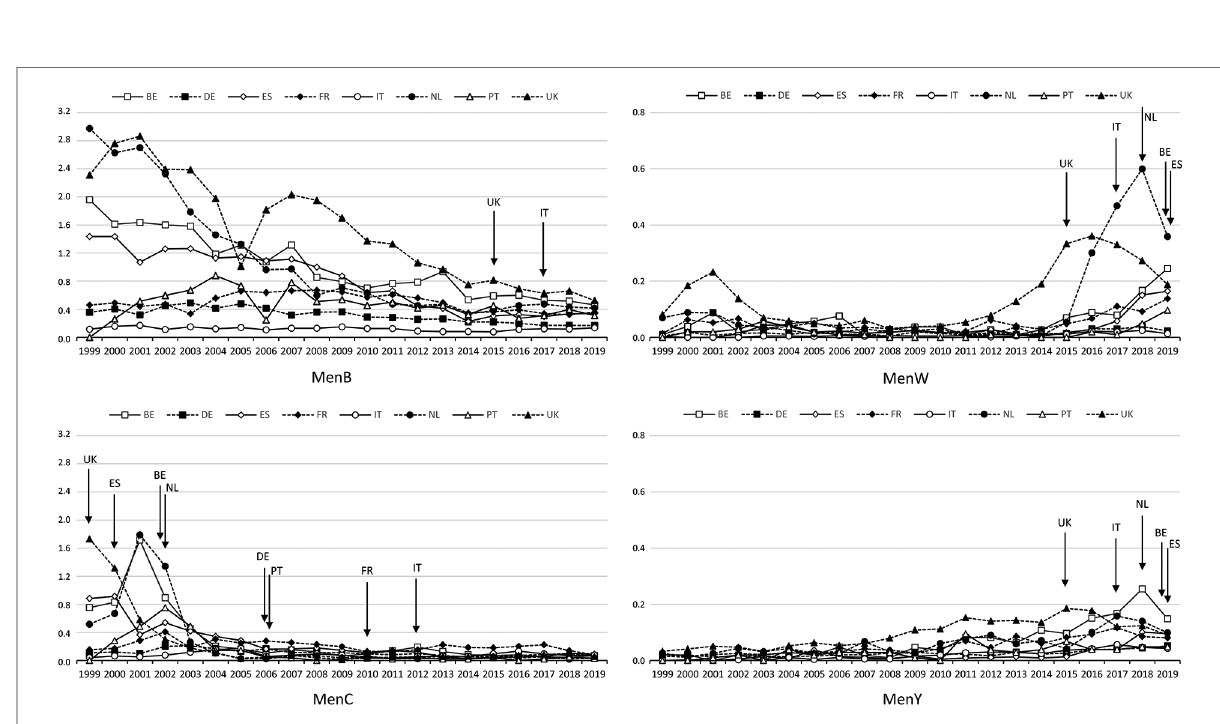
FIGURE 2 Noti fi cation rates of con fi rmed cases* ( N /100,000) from 1999 † to 2019 by country and by serogroup. BE, Belgium; DE, Germany; ES, Spain; FR, France; IT, Italy; NL, Netherlands; PT, Portugal; UK, United Kingdom. *Con fi rmed case of IMD is de fi ned as any person meeting at least one of the following laboratory criteria: isolation of N. meningitidis from a normally sterile site, or purpuric skin lesions; detection of N. meningitidis nucleic acid from a normally sterile site, or purpuric skin lesions; detection of N. meningitidis antigen in cerebrospinal fl uid; detection of Gram- negative stained diplococcus in cerebrospinal fl uid. † No data for PT in 1999. Arrows indicate vaccination introduction; pattern fi lls indicate the country introducing vaccination in its vaccination program.